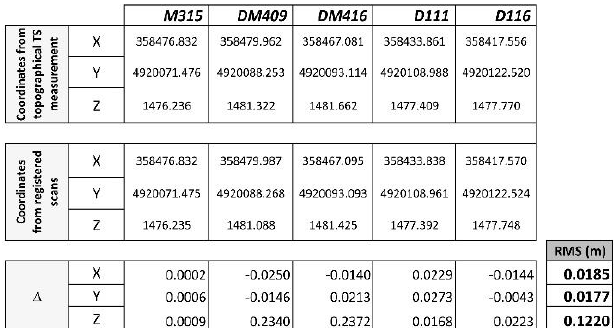
Figure 15. Marked CPs and measured coordinates on the target in registered cloud for a following comparison with TS measured coordinates (Table 5).